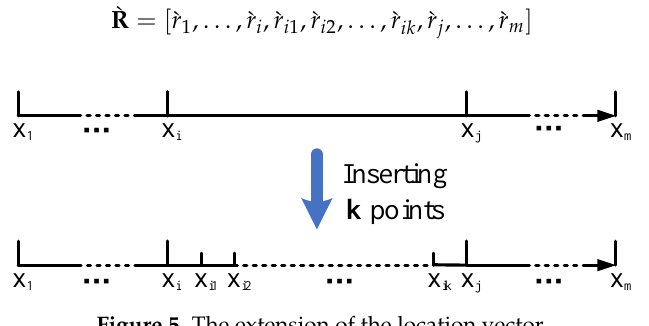
Figure 5. The extension of the location vector.